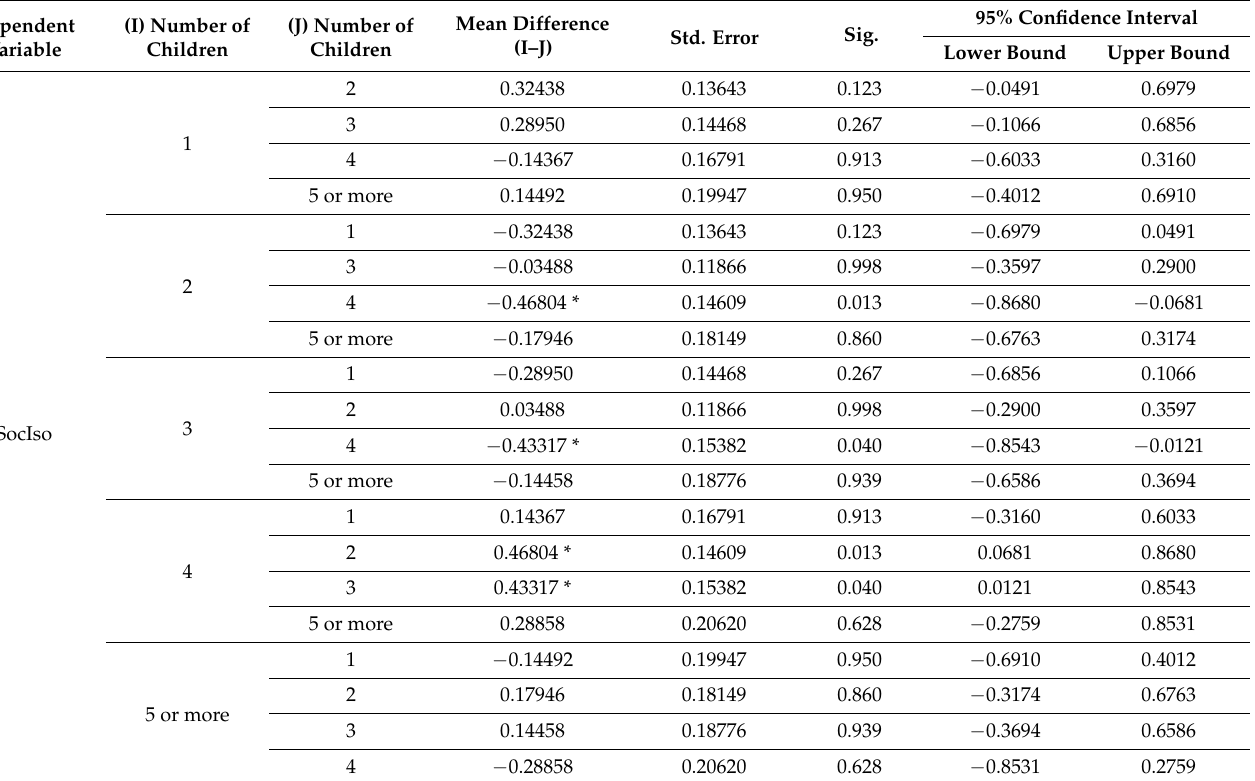
Table 17 provides the statistical significance of the differences between each pair of groups for the number of children in a family. As observed in Table 16, the five groupings were statistically different from one another. Table 17. Multiple comparisons analysis of the SocIso attributed to the number of children in the family using Tukey HSD.